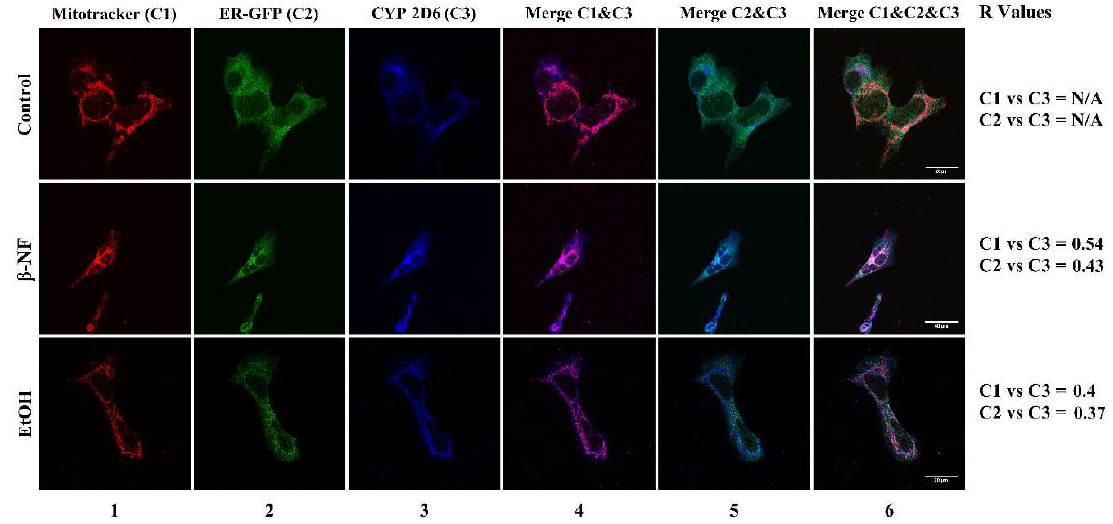
Figure 4. Immunostaining of CYP2D6 in SH-SY5Y cells after β-NF and EtOH treatment. Representative immunofluorescence images of each experimental condition. Column 1 represents mitochondrial stain (red), column 2 represents ER-Green Fluorescent Protein (GFP) stain (green), and column 3 reports the CYP2D6 staining (blue). Column 4 represents the merge between CYP2D6 and mitochondria channel, column 5 represents the merge between CYP2D6 and ER-GFP, and column 6 represents the merge of the three channels. R Values: Pearson’s correlation coefficient. N/A: Not determined. Scale bars: 20 µm (control and EtOH) and 40 µm (β-NF).